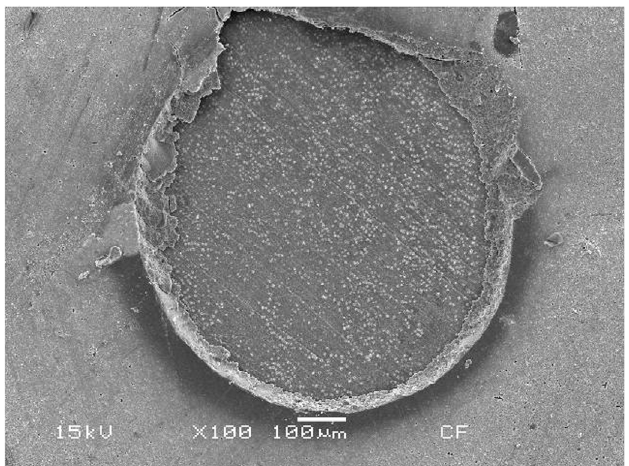
Fig. 4 - SEM photomicrograph illustrating an adhesive failure along the dentin for group Clearfil SA Cement (light-cured).